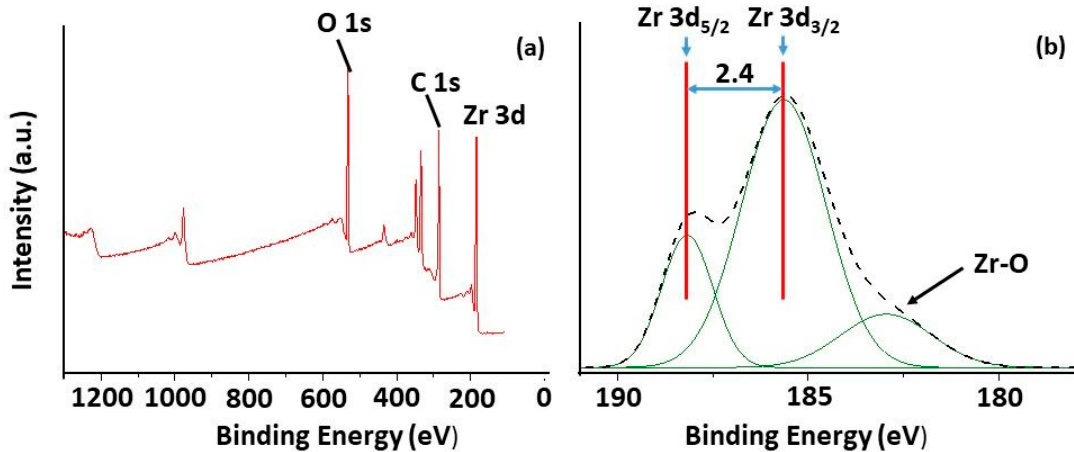
Figure 7. (a) XPS survey spectrum of HRG@ZrO 2 nanocomposite. (b) The Zr 3d level XPS spectrum of HRG@ZrO 2 nanocomposite.